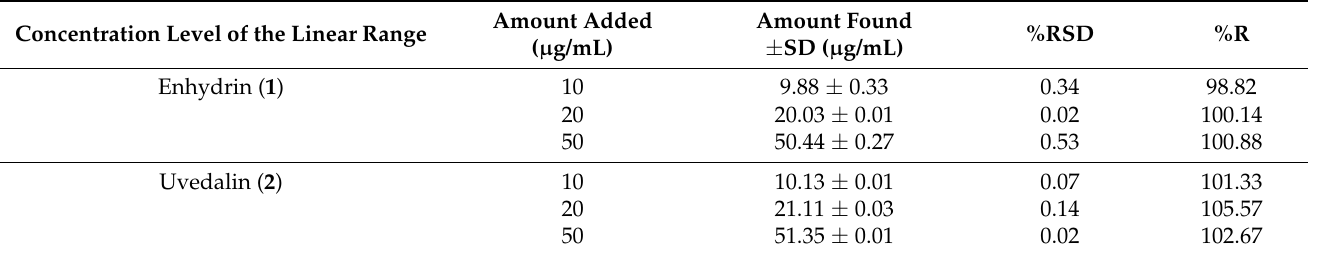
Table 3. Data of the HPLC method’s precision at repeatability levels for the compounds 1 and 2 quantifications (n = 9).